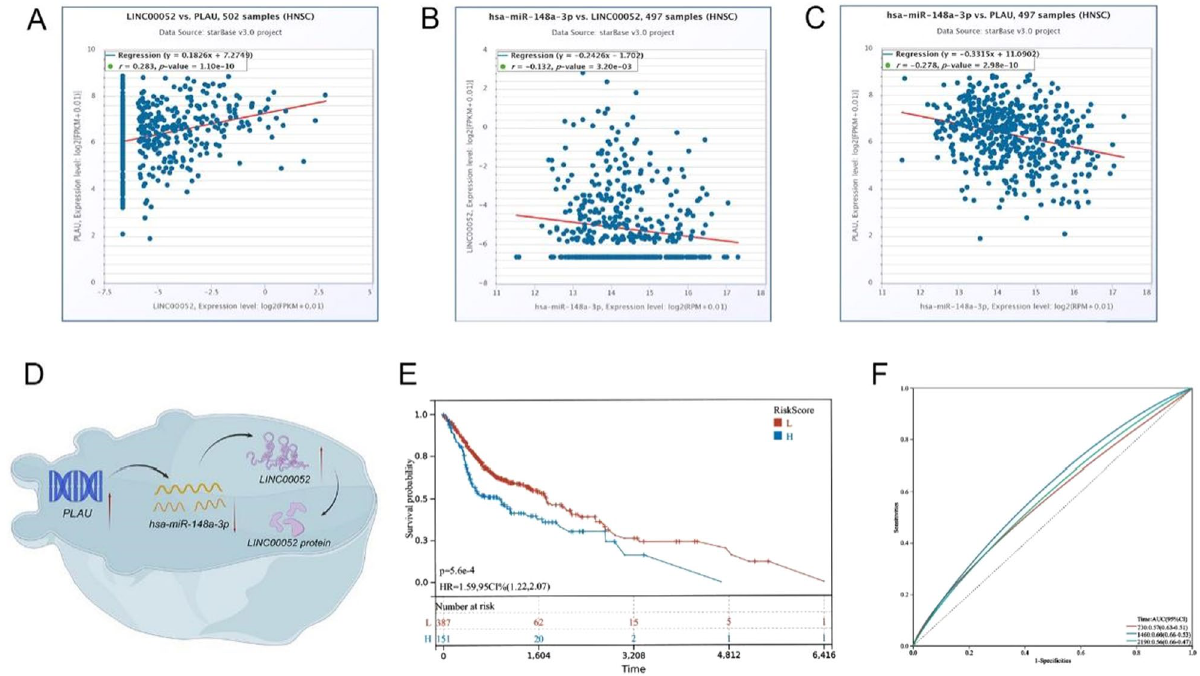
Figure 6. ( A – C ) Co-expression correlation analysis of qualified ceRNA network. ( D ) Schematic representations of the immune-related ceRNA network. ( E ) Kaplan–Meier survival curve by the risk score of the TCGA-HNSC dataset. ( F ) Time-dependent ROC curve analysis for survival prediction based on the risk